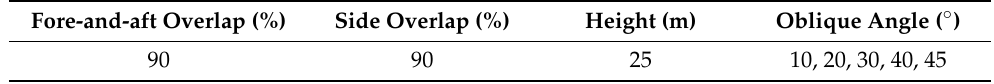
Table 1. Parameters for flight path planning. Fore-and-aft Overlap